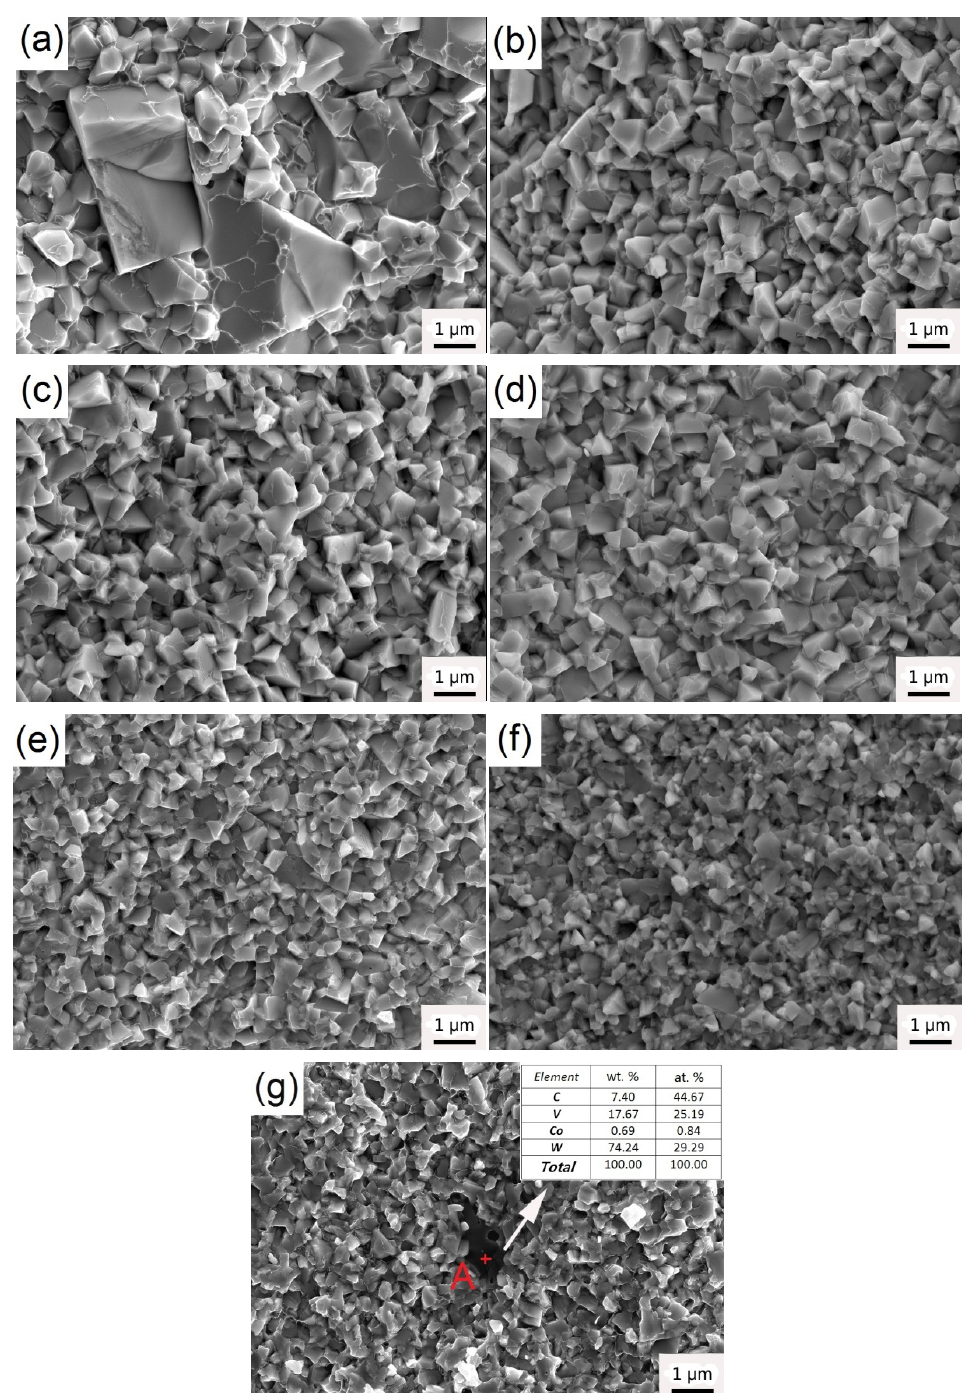
Figure 10. SEM images showing fracture surfaces of WC–6Co–(Cr 2 C 3 /VC) cemented carbides. ( a ) WC–6Co; ( b ) WC–6Co–0.25Cr 3 C 2 ; ( c ) WC–6Co–0.6Cr 3 C 2 ; ( d ) WC–6Co–1.0Cr 3 C 2 ; ( e ) WC–6Co–0.25VC; ( f ) WC–6Co–0.6VC; ( g ) WC–6Co–1.0VC.